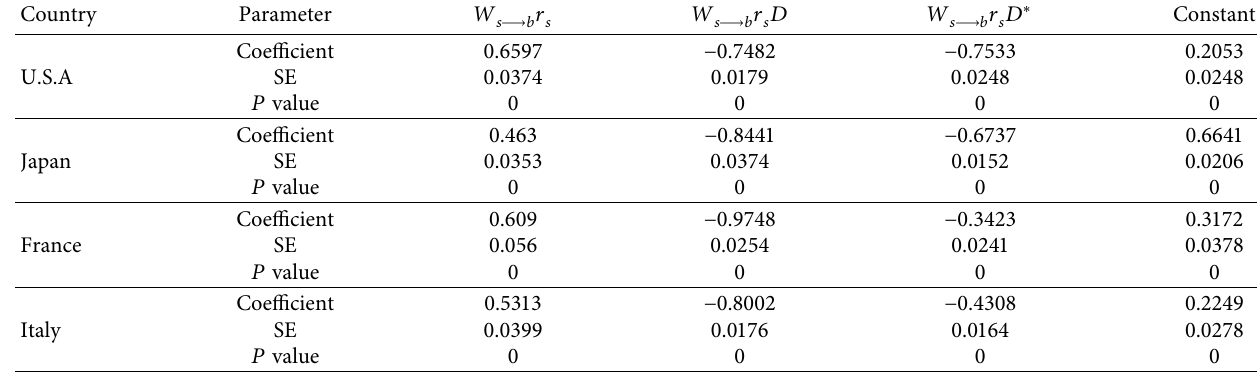
Table 1: Estimated results of the mean equation of the GARCH (1,1) model for four countries.